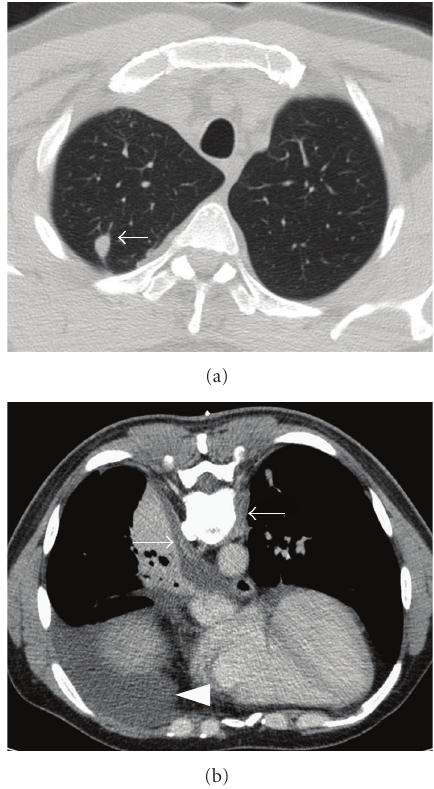
Figure 1: (a) CT scan revealing a nonspecific nodule in the right upper lobe (arrow). (b) Contrast enhanced CT in prone position shows right pleural e ff usion (arrowhead) and bilateral sub pleuralthickening (arrow) in the region of the 9th vertebrae.